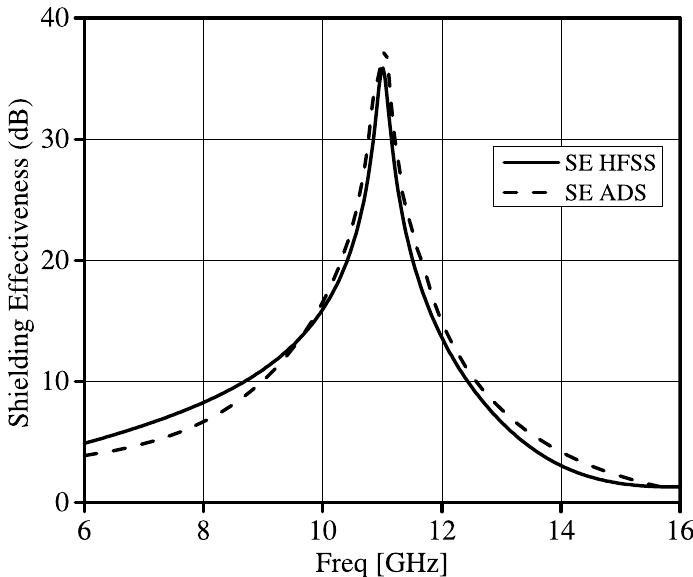
Figure 3. A comparison of the shielding effectiveness (SE) results of the EM simulation and circuit